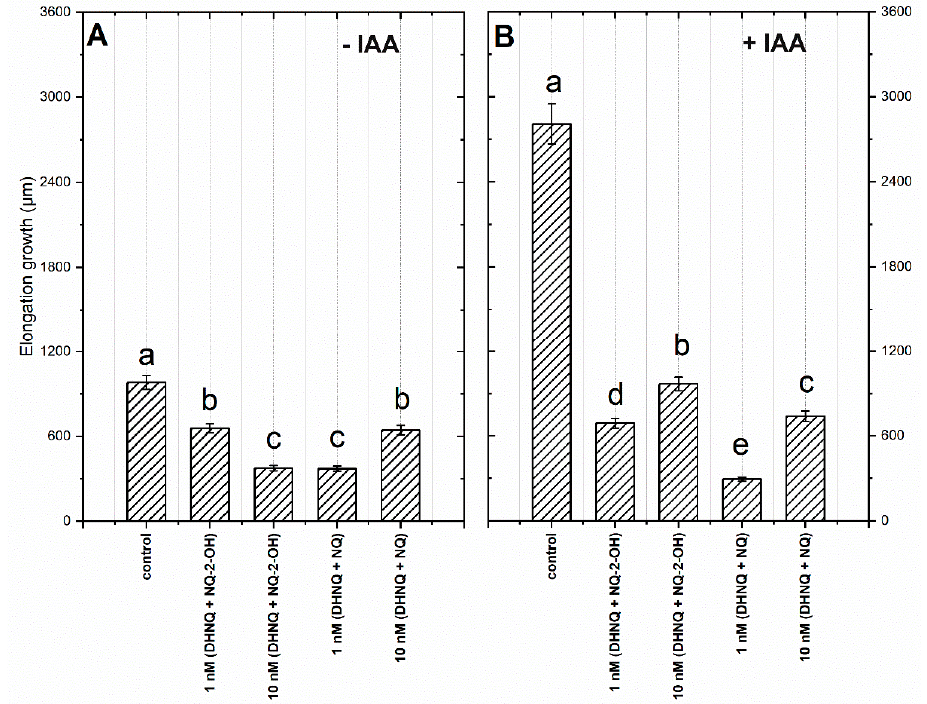
Figure 2. The effect of DHNQ combined with NQ-2-OH or NQ on the cumulative growth of the maize coleoptile segments that were incubated without ( A ) and with IAA ( B ). The figure shows the differences between the cumulative growth per coleoptile segment at 600 and 120 min. Mean values that are followed by the same letter within a group were not significantly different from each other. The presented data is the mean of six independent experiments. Bars indicate the means ± SEs. When naphthazarin (DHNQ) combined with lawsone (NQ-2-OH) or 1,4-naphthoquinone (NQ) was added to a medium, there was a decrease in the IAA-induced growth of the maize coleoptile segments of more than 60% (Figure 2B). Interestingly, the most detrimental combination of all of the tested treatments was naphthazarin combined with 1,4-naphthoquinone at 1 nM, which reduced the IAA-induced growth by ca. 90%. Moreover, in order to compare the effects of naphthazarin combined with lawsone or 1,4- naphthoquinone on the endogenous and IAA-induced cumulative growth, a t-test was performed. This statistical analysis showed that there were statistically significant differences between the endogenous and auxin-induced growth of the maize coleoptile segments in all of the treatments that were studied. Taking the results into account, it can be suggested that in the presence of IAA, the mechanism of action of naphthoquinones applied together can complement each other and have a more negative effect. 2.2. Proton Concentration in the Incubation Medium of the Coleoptile Segments The simultaneous measurements of the growth and pH of the external medium indicated that the coleoptile segments changed the pH of the medium. This characteristic change of pH of the incubation medium occurred when an increase of the pH from 5.8–5.9 to 6.0–6.2 during the first 2 h was initially recorded, followed by a slow decrease to a pH of approximately 5.6–5.7 after 10 h. When the IAA at a final concentration of 100 µM was added to the incubation medium 2 h after the start of the experiment, there was an additional decrease in the pH to ca. 4.8 after 10 h of experiment (for a comparison see Rudnicka et al., 2019). In order to present the pH changes in the medium much more suggestively, they are shown as changes in the H + concentration per coleoptile segment (Figure 3).